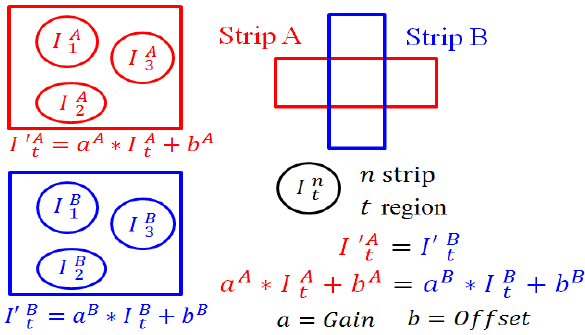
Figure 6. Illustration of multi-strip adjustment for strips A and B.